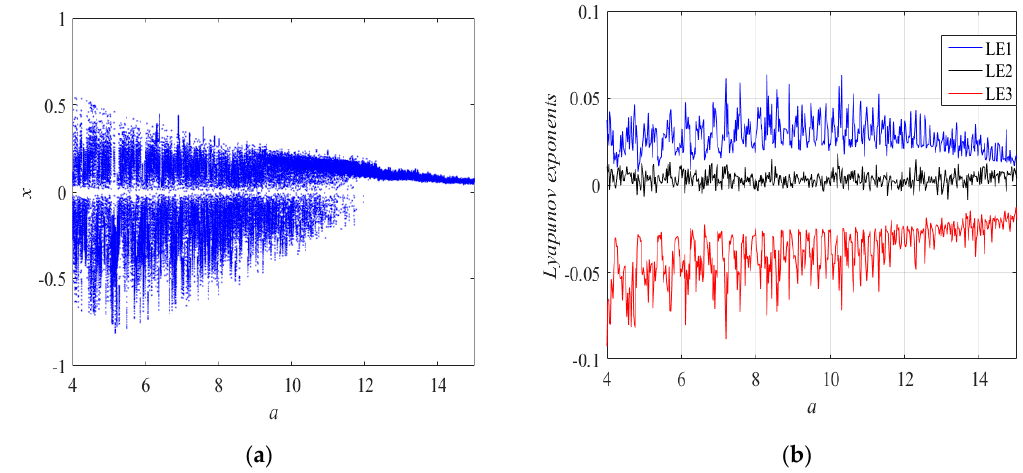
Figure 3. ( a ) Bifurcation diagram of System (2) with respect to parameter a and ( b ) Lyapunov exponent spectrum of the system with respect to parameter a.